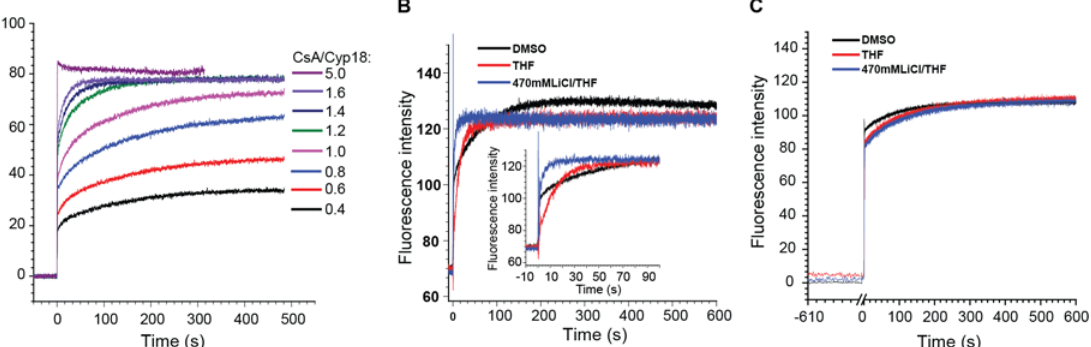
Fig 1. Conformational heterogeneity of CsA in Cyp18 binding. ( A ) Fluorescence intensity time courses of Cyp18 (final concentration of 500 nM) upon the addition of various concentrations of CsA using stopped flow. The graph is plotted after subtraction of the initial fluorescence intensity of free Cyp18. Results shown are the average of two independent experiments. The values shown in the inset represent the different ratios of CsA to Cyp18. ( B ) Fluorescence intensity time courses of Cyp18 upon the addition of CsA dissolved in DMSO (Black), THF (Red) and LiCl/THF (Blue) under continuous stirring. The graph is plotted after subtraction of the reference curve. Results shown are the average of two independent experiments. The inserted graph represents the scale from -10 s to 100 s. ( C ) Fluorescence intensity time course of Cyp18 upon binding to CsA after incubation in HEPES buffer for 10min (black, red and blue curves are CsA dissolved in DMSO, THF and LiCl/THF before adding to HEPES buffer, respectively). The graph is plotted after subtraction of the reference curve. Results shown are the average of two independent experiments.